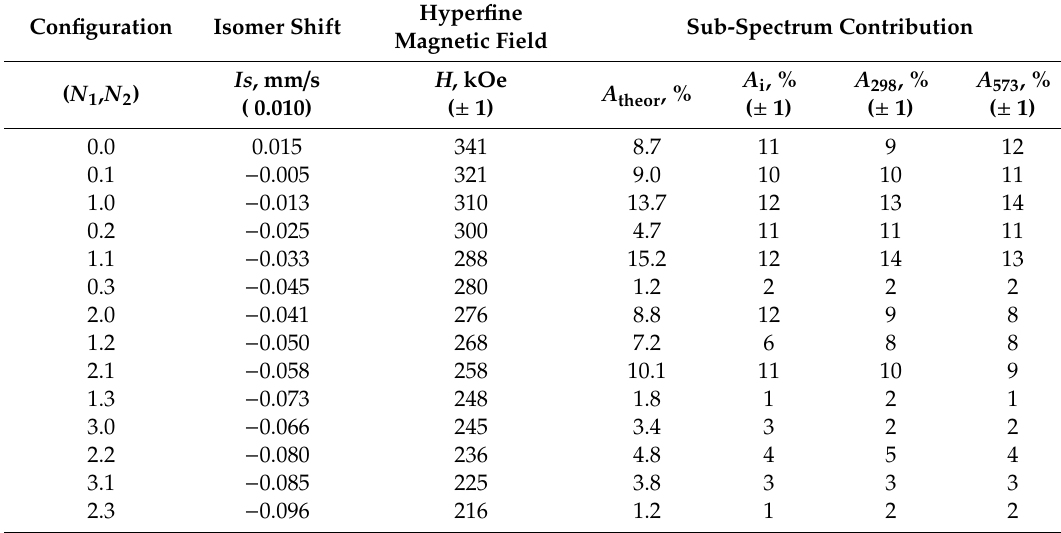
Table 4. Hyperfine parameters* and contributions of subspectra for the Fe-16Cr-Au alloy. Subspectra contributions are presented for random distribution ( A theor ), initial state ( A i ) and after HPT at 298 K ( A 298 ) and 573 K ( A 573 ).